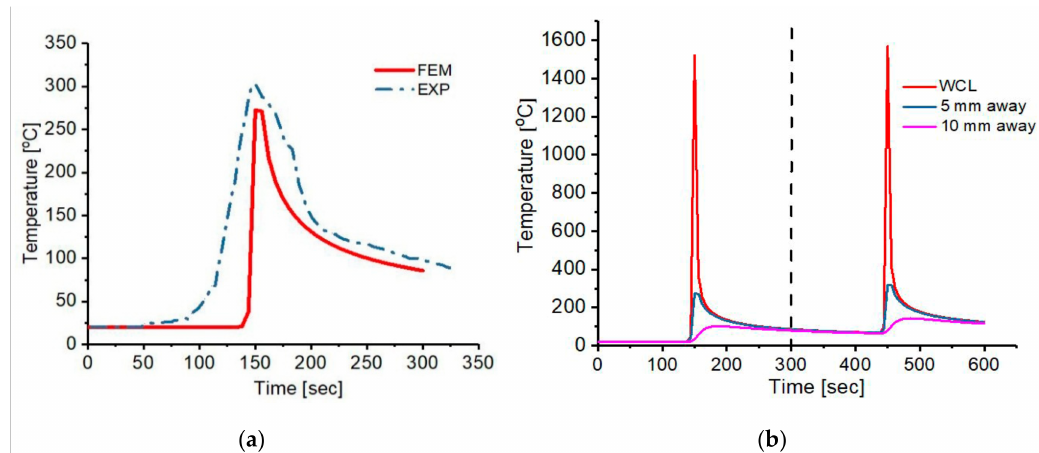
Figure 11. Thermal distribution.